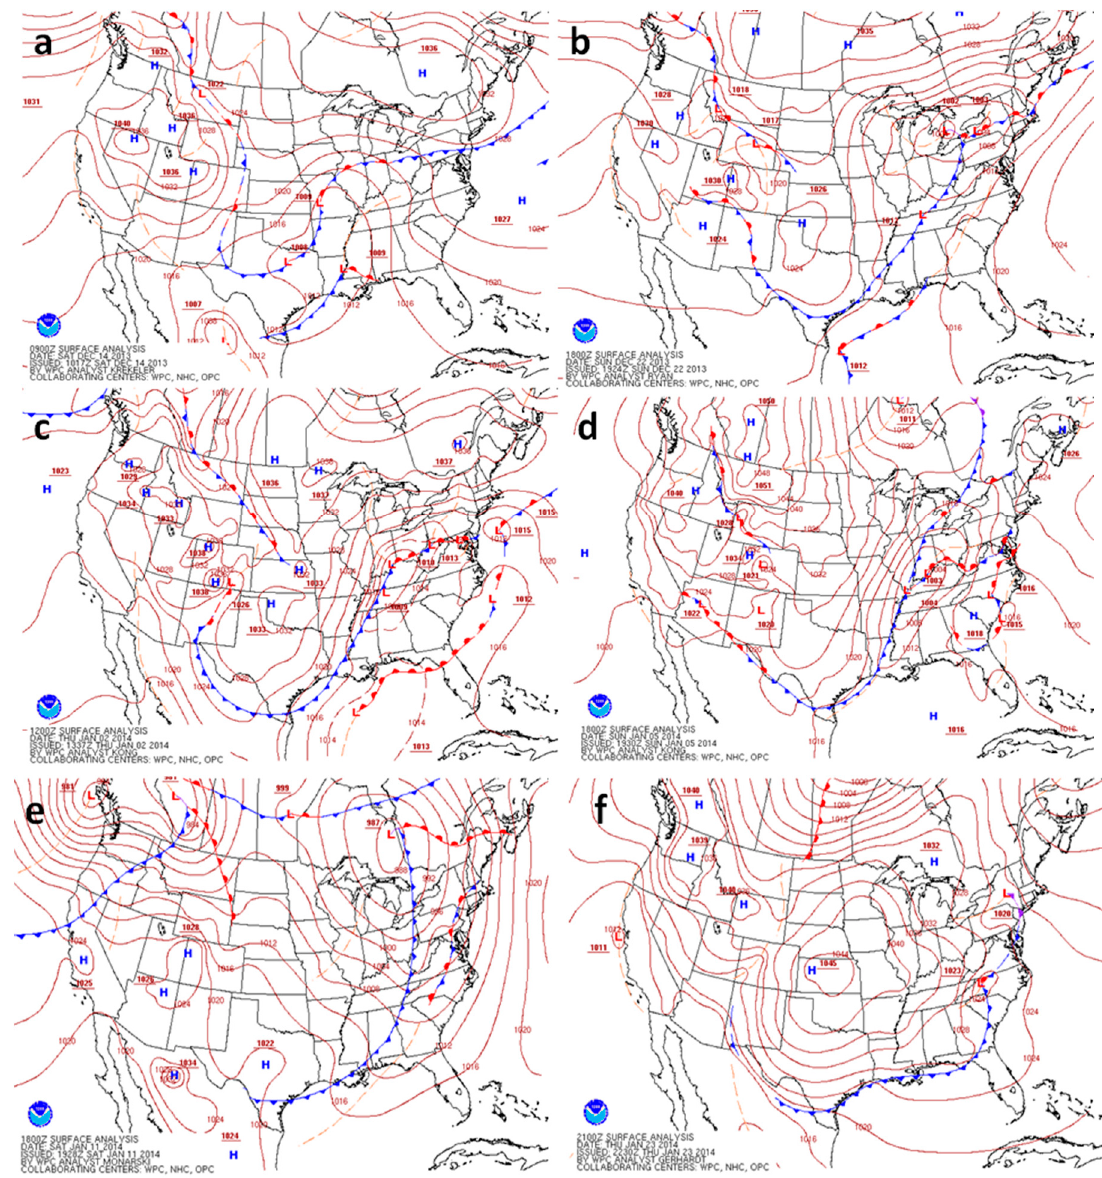
Figure 4. Weather map from NOAA. ( a ) 14 Dec. 2013; ( b ) 22 Dec. 2013; ( c ) 2 Jan. 2014; ( d ) 5 Jan. 2014; ( e ) 11 Jan. 2014; ( f ) 23 Jan. 2014.